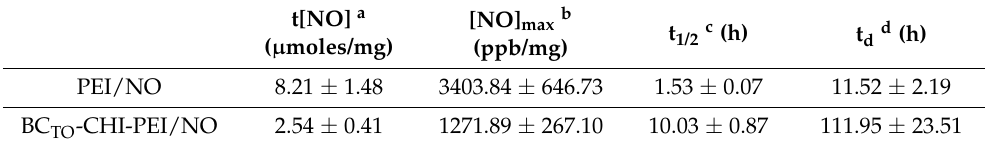
Figure 2. ( A ) BC TO -CHI and ( E ) BC TO -CHI-PEI/NO hydrogels in simulated wound fluid (SWF). Lyophilized ( B ) BC TO -CHI and ( F ) BC TO -CHI-PEI/NO. Scanning electron microscopy (SEM) images of ( C ) BC TO -CHI and ( G ) BC TO -CHI-PEI/NO hydrogels. ( D ) SEM images of a cross-section of the BC TO -CHI and ( H ) BC TO -CHI-PEI/NO. Table 1. NO-release properties (pH 7.4, 37 ◦